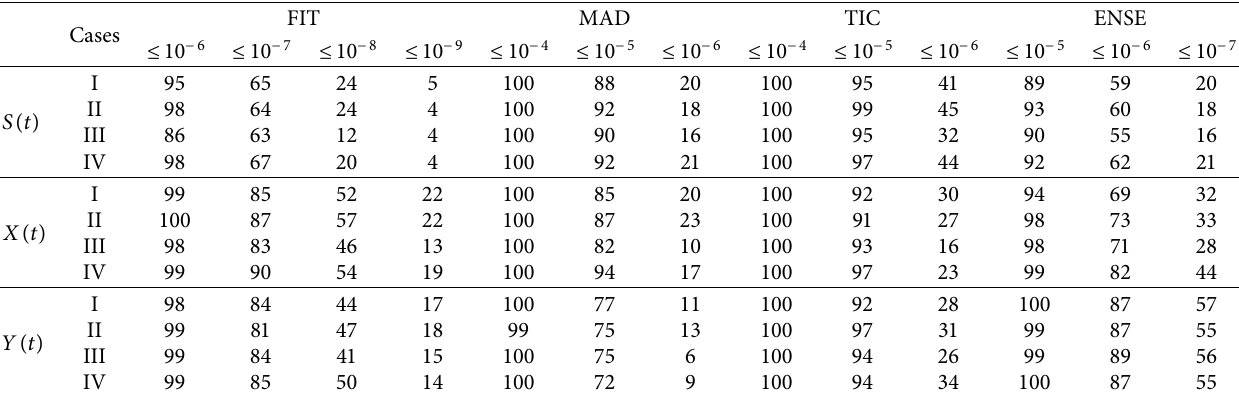
Table 42: Convergence analysis of population density of local prey, immigrant prey, and predator under the influence of variations in c